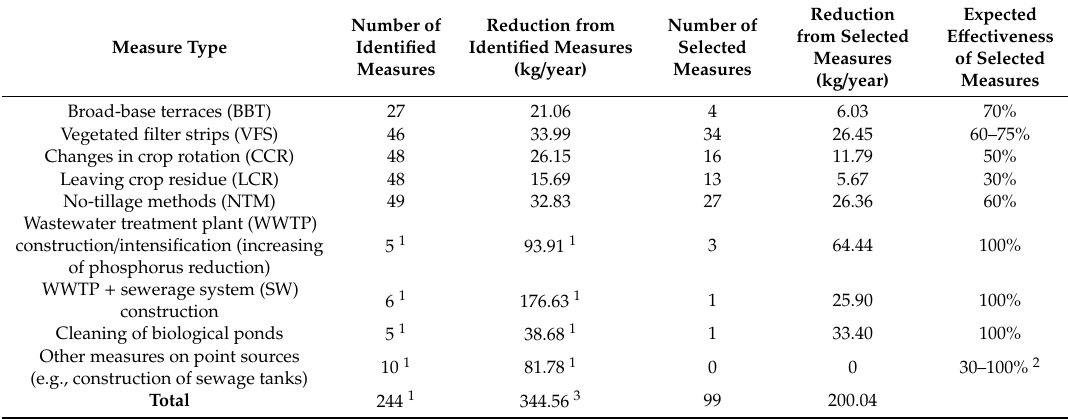
Table 1. Measures entering the cost-e ff ectiveness analysis and selected most e ffi cient measures that theoretically reduce 200 kg / year of phosphorus